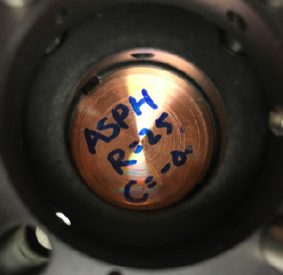
Figure 7. The measured aspherical mirror.